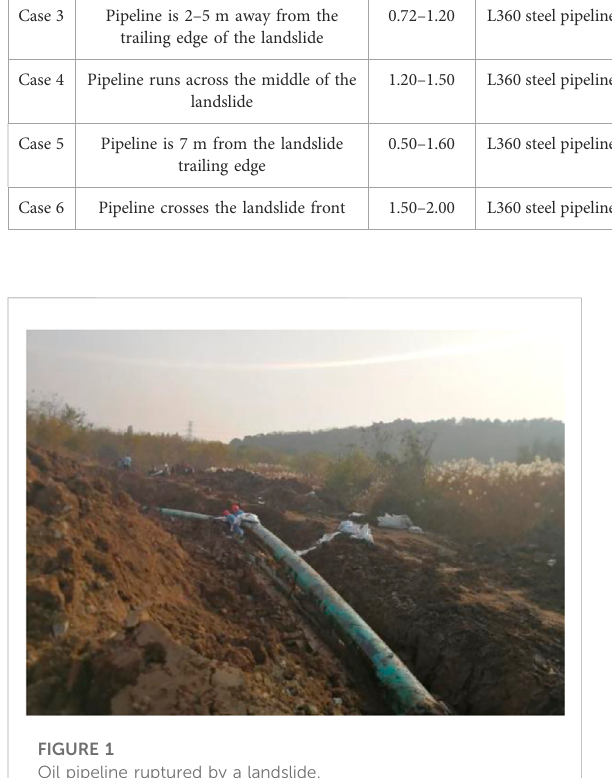
FIGURE 1 Oil pipeline ruptured by a